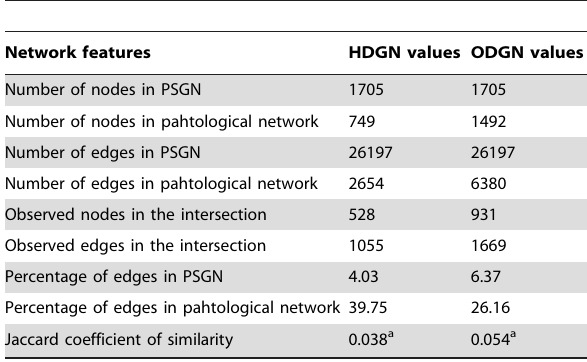
Table 4. Network intersection analysis between PSGN and HDGN or